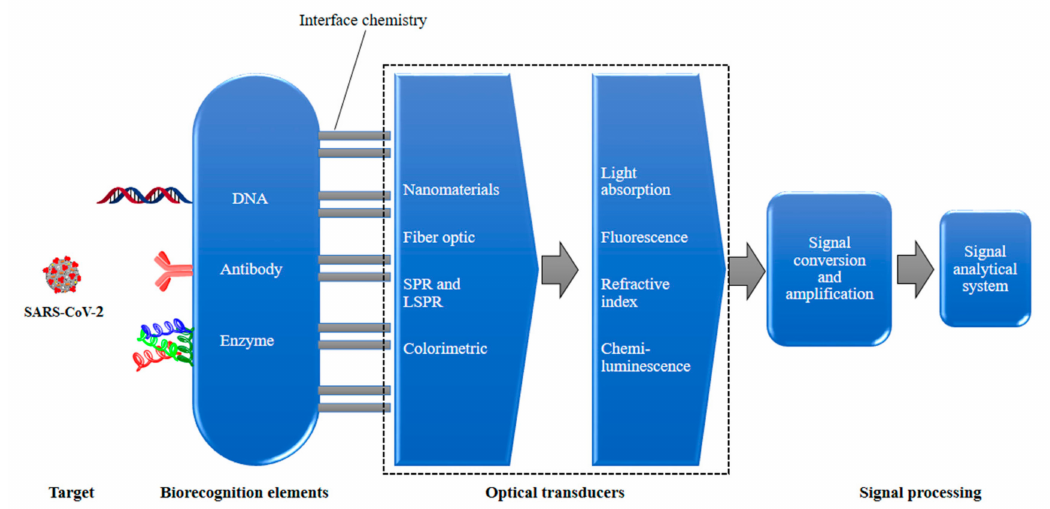
Figure 5. A schematic of an optical biosensor.